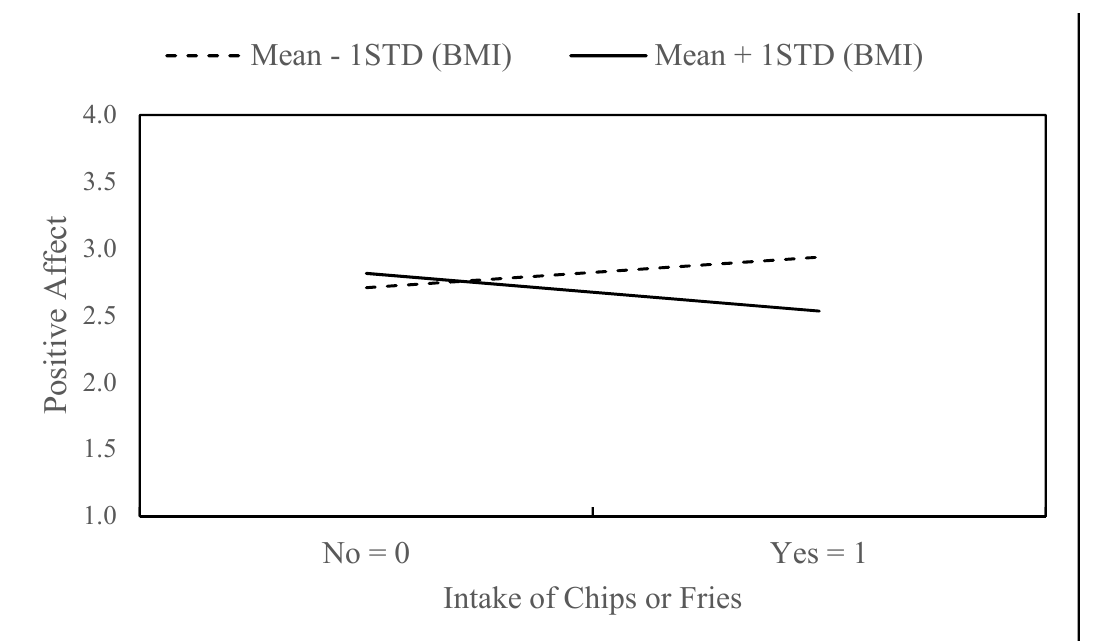
Figure 5. Two-way interaction of within-subjects chips or fries intake and pre-pregnancy BMI predicting positive affect. The x-axis includes times when women indicated not consuming chips/fries or consuming chips/fries. The y-axis represents the mean level of positive affect.